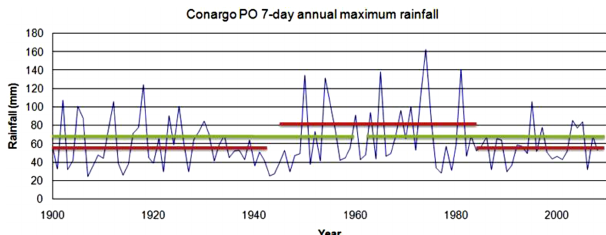
Figure 4. Example of inadequate identification of non-stationarity using the CUSUM test (red line highlights three distinct epochs of high/low rainfall, while green line demonstrates effect of splitting the data into two sections for the CUSUM